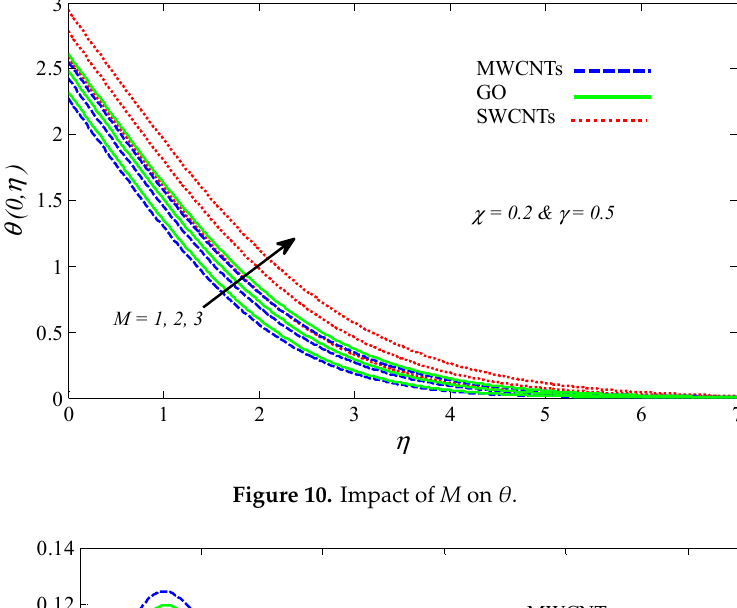
Figure 11. Impact of M on / F